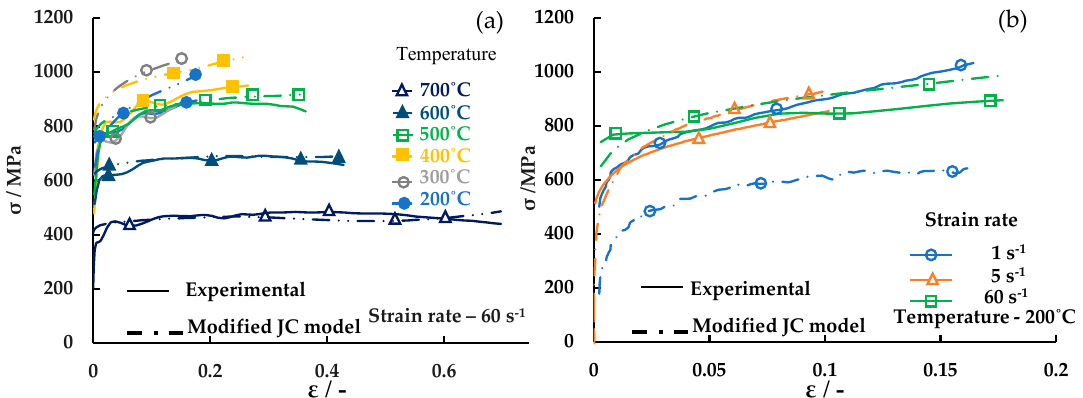
Figure 8. Modified J-C model predicted true stress versus true plastic strain curves ( a ) at different temperatures at a constant strain rate of 60 s − 1 and ( b ) at different strain rates at a constant temperature of 200 °C.